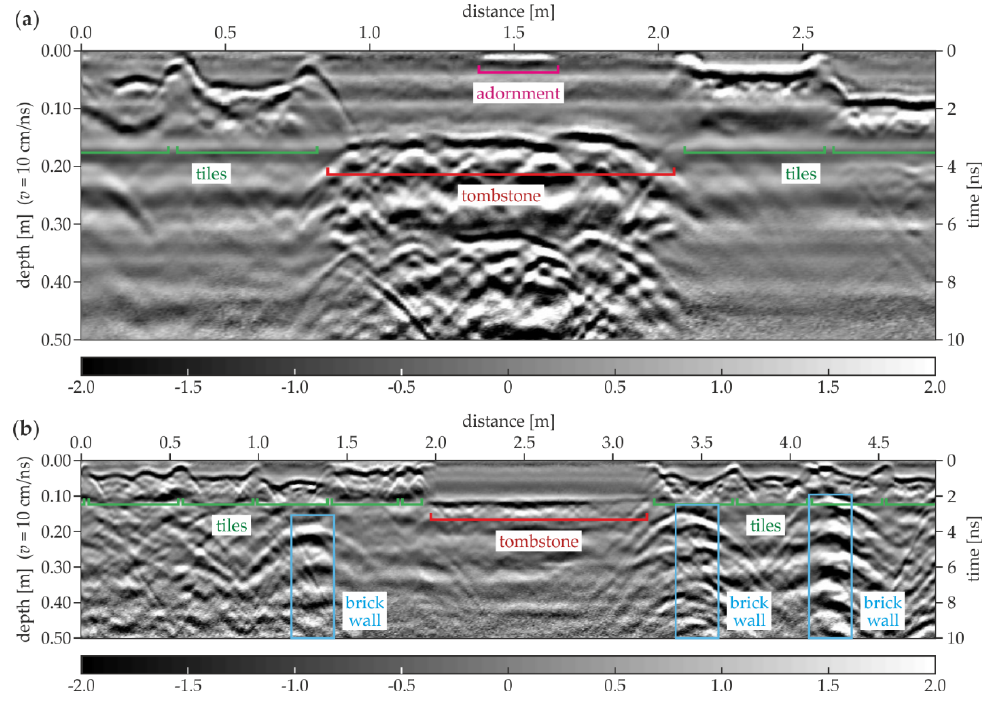
Figure 17. GPR B ‐ scans for the south aisle (survey A): ( a ) A ‐ 19; ( b ) A ‐